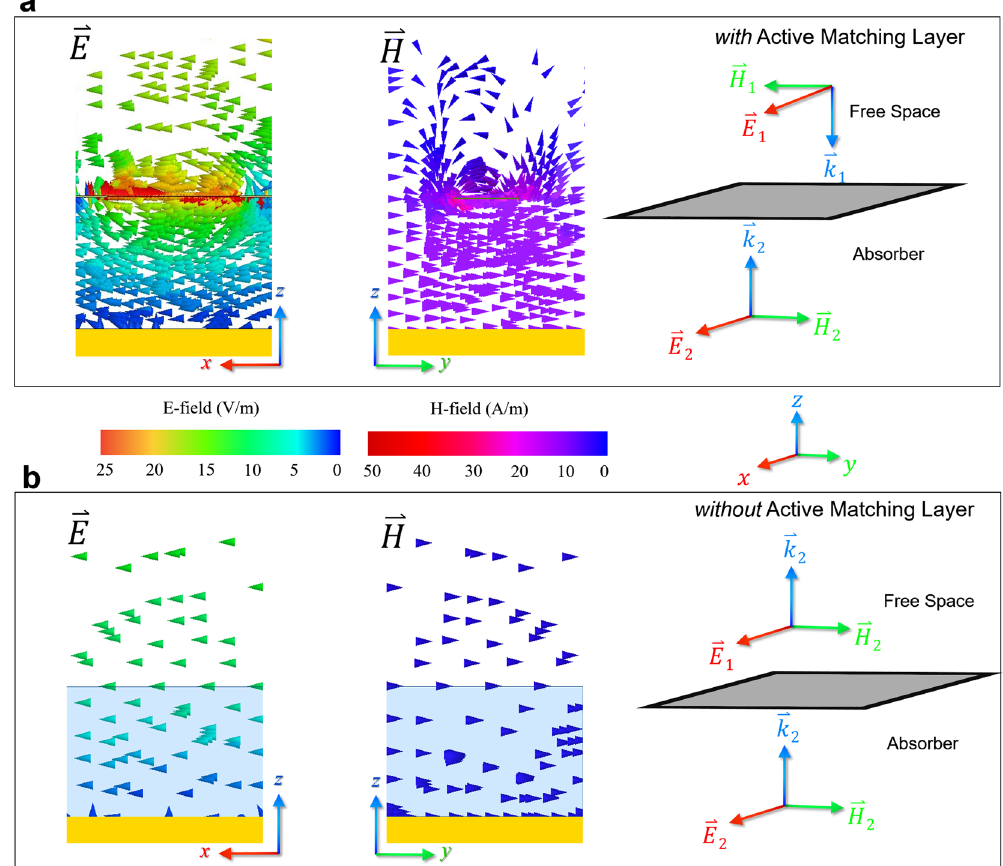
Figure 3. Physical Insight based on EM-field distributions. ( a ) NFMS magnetic absorber. ( b ) CBMS without coatings. E-field only distribute in xoz -plane and H-field only distribute in yoz